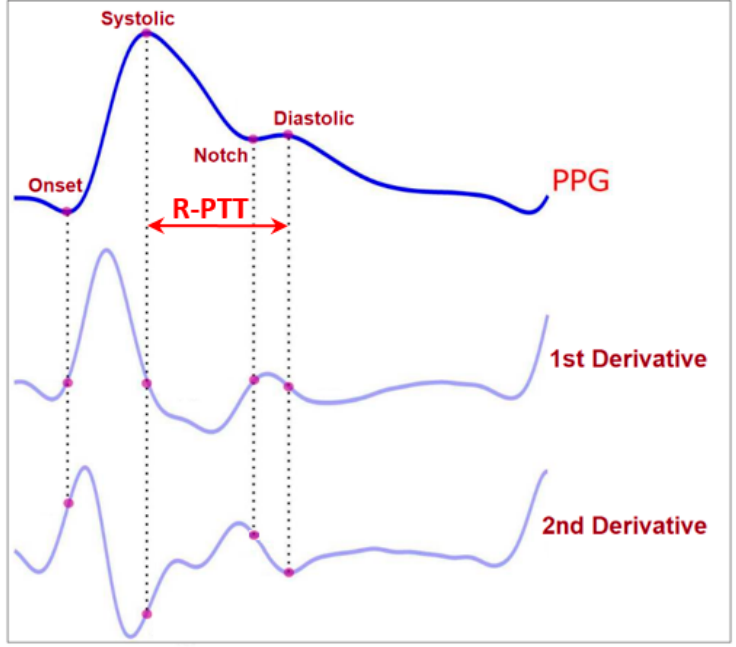
Figure 5. Illustration of the PPG signal and its first and second derivatives. The second derivative can locate the peak of the reflected wave (diastolic peak). The difference between the systolic peak and diastolic peak, in time, represents the reflective PTT (R-PTT) indicated by the horizontal line in the figure. (Adapted with modification from [41].)